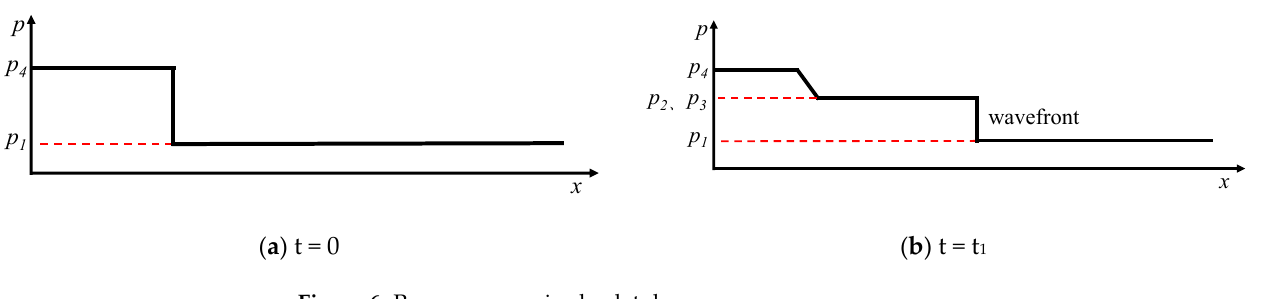
Figure 6. Pressure curve in shock tube.